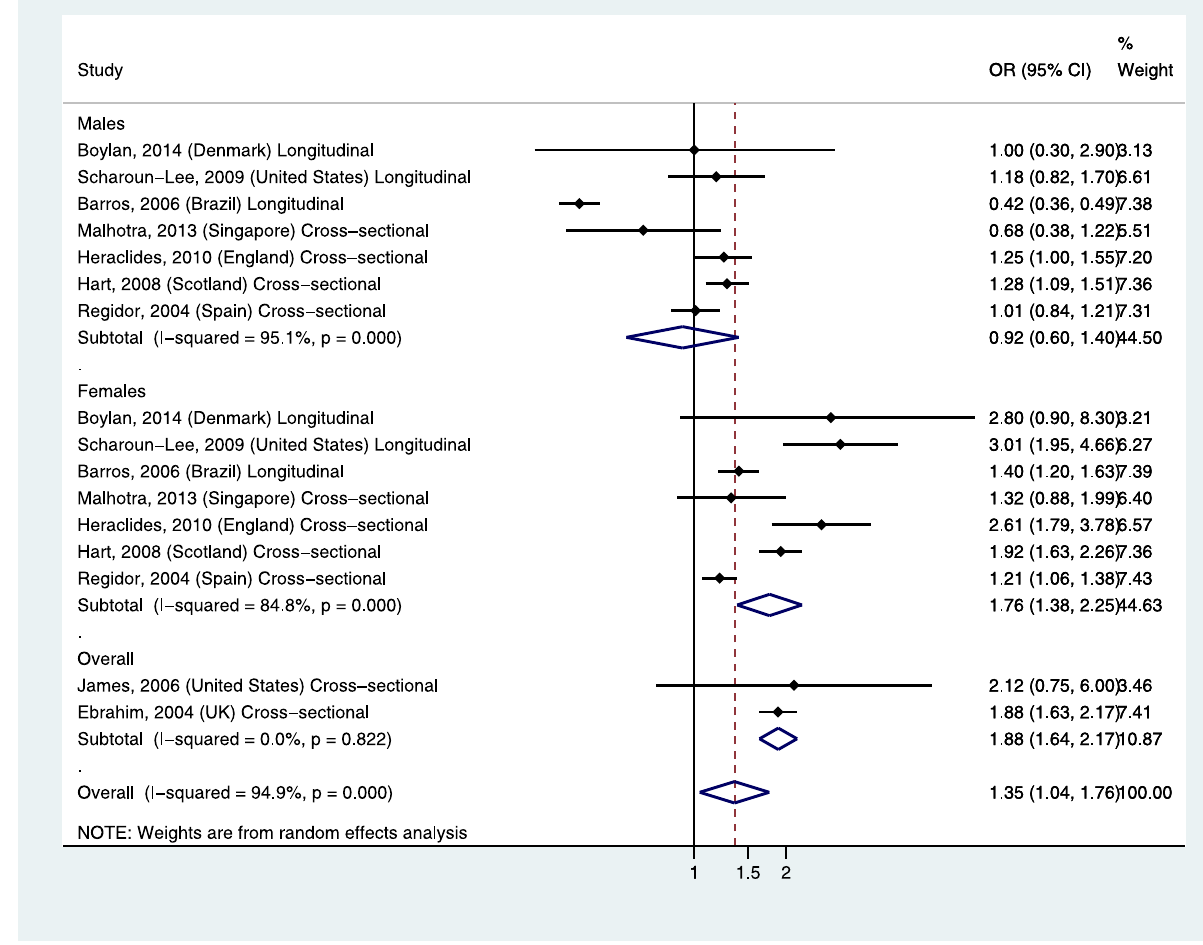
Fig 3. Summaryodds ratio for obesity by life course SES.